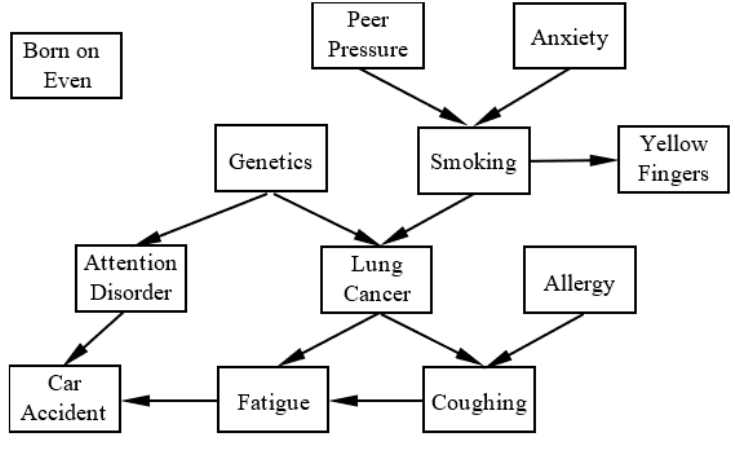
Figure 4. DAG of LUCAS0.